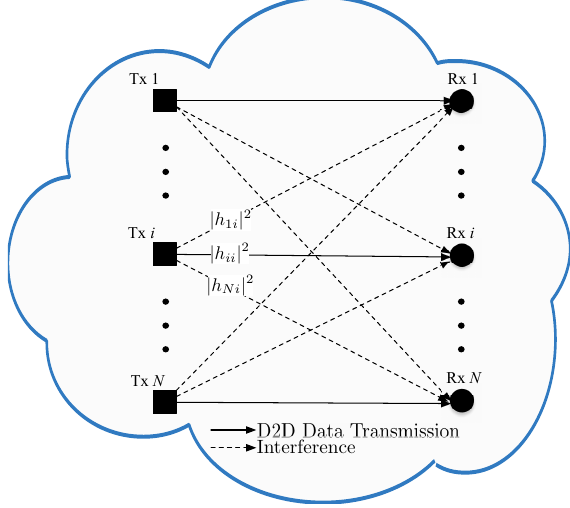
Figure 1. An illustration of a D2D communication network with N